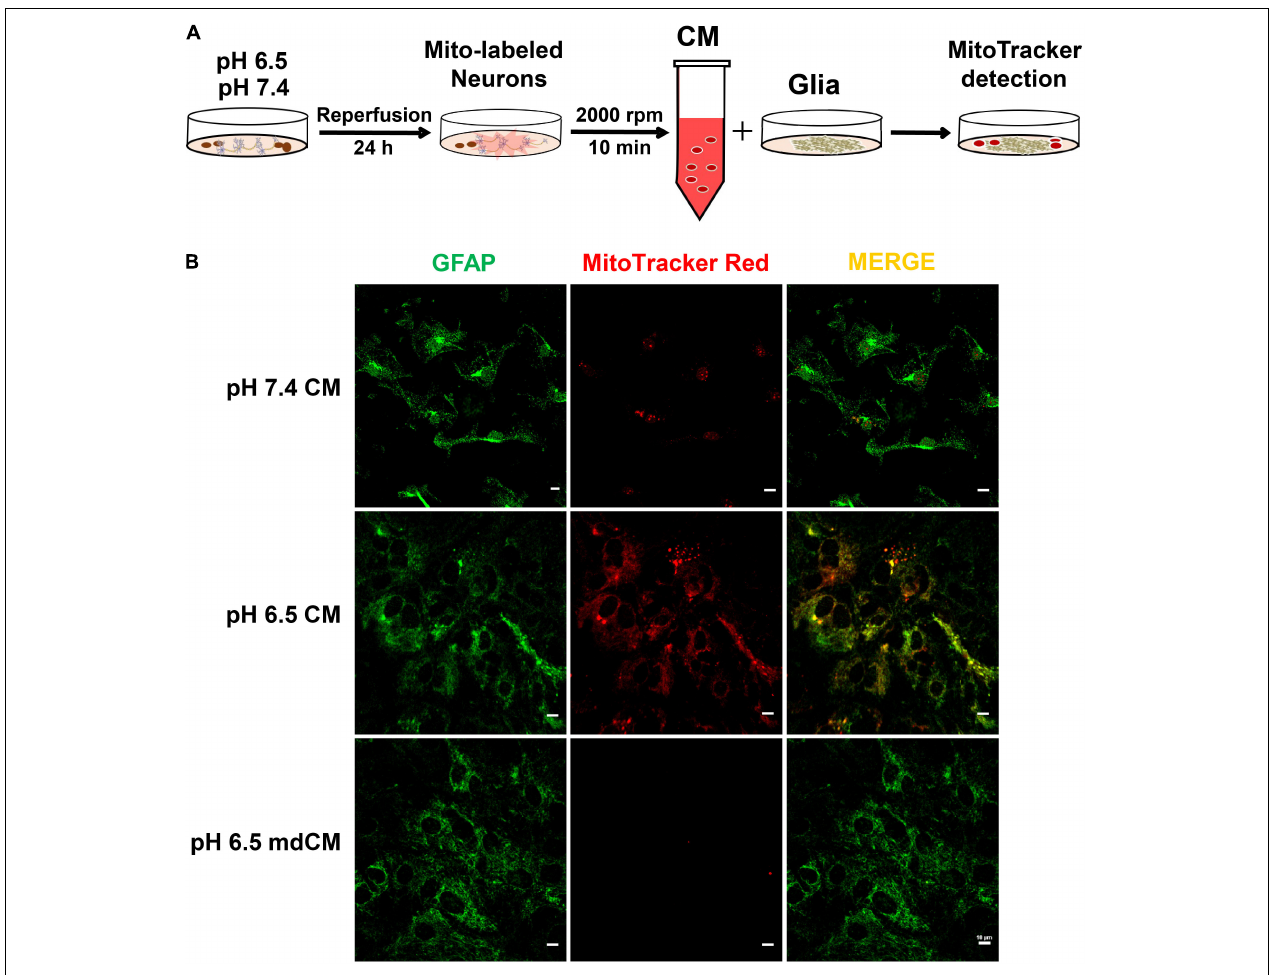
FIGURE 5 | The mitochondria released from neurons were taken up by astrocytes. (A) Experimental schematic to detect the cross-talk between neurons and astrocytes after treatment with pH 7.4 and 6.5 solutions. The neurons were labeled by MitoTracker Red CMXRos, and the astrocytes were labeled with GFAP. (B) The mitochondria with MitoTracker Red CMXRos were rarely detected within the astrocytes after co-culture with CM from pH 7.4-treated neurons. However, the co-localization of MitoTracker Red CMXRos with GFAP was increased when co-culture with CM from pH 6.5-treated neurons, and the increase was abolished by removing the mitochondria with a 0.2 µ m